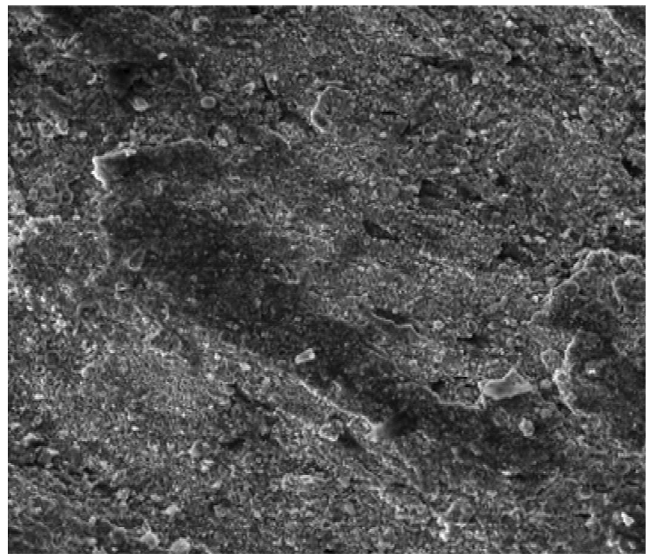
Figure 10. SEM microstructure of grey cast iron carburized at 900 °C for 90 min.